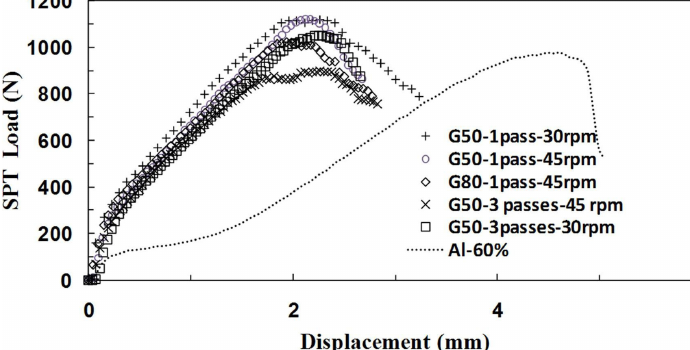
Figure 7. Experimental results of SPT specimens for different samples